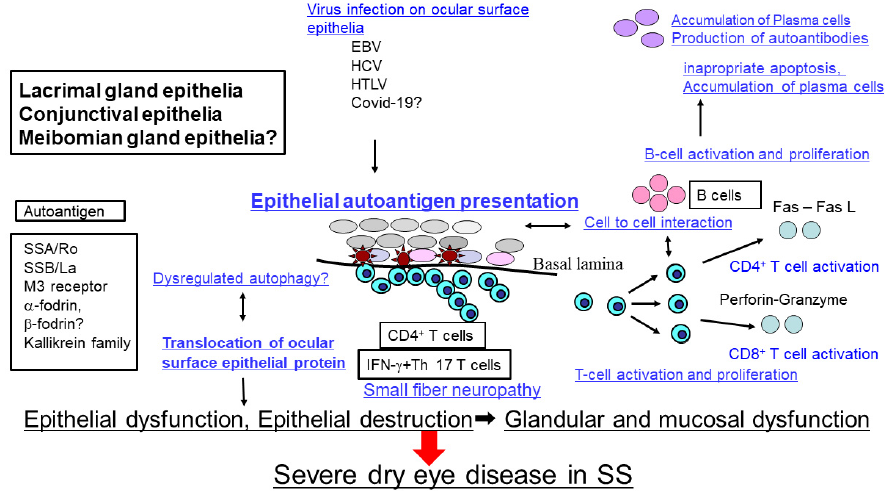
Figure 2. Hypothetical schema of pathophysiology of Sjogren’s syndrome related dry eye disease.